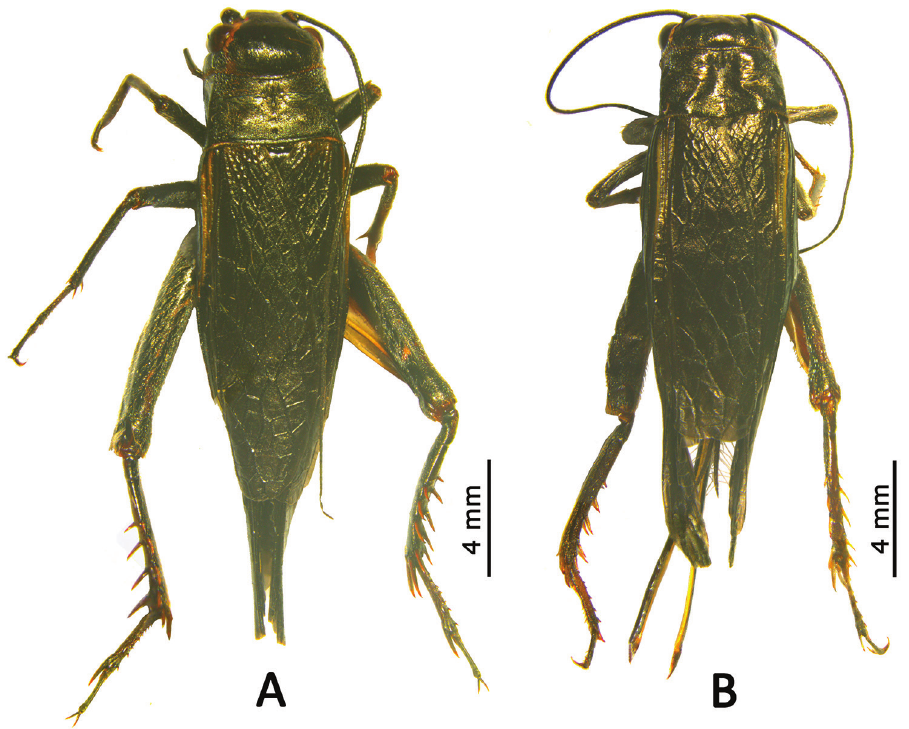
Figure 2. Habitus of Qingryllus jiguanshanensis sp. n., dorsal view. A male B female.